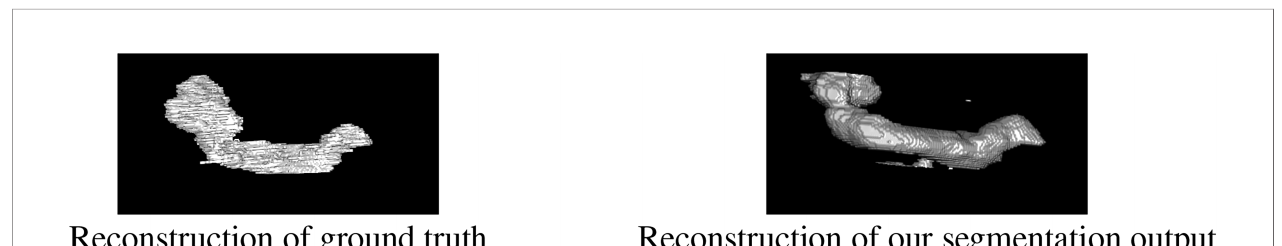
FIGURE 5 | The results of 3D rebuilding. The left picture is the reconstruction of ground truth, and the right picture is the reconstruction of the segmentation output of our